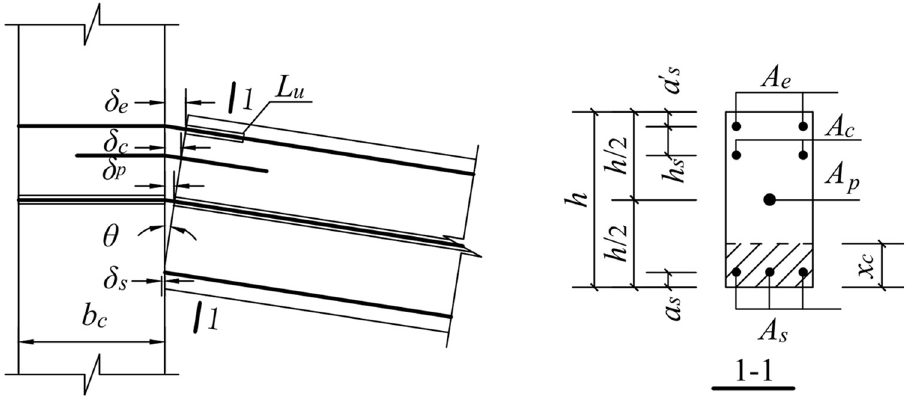
Fig 26. Mechanical model for downward